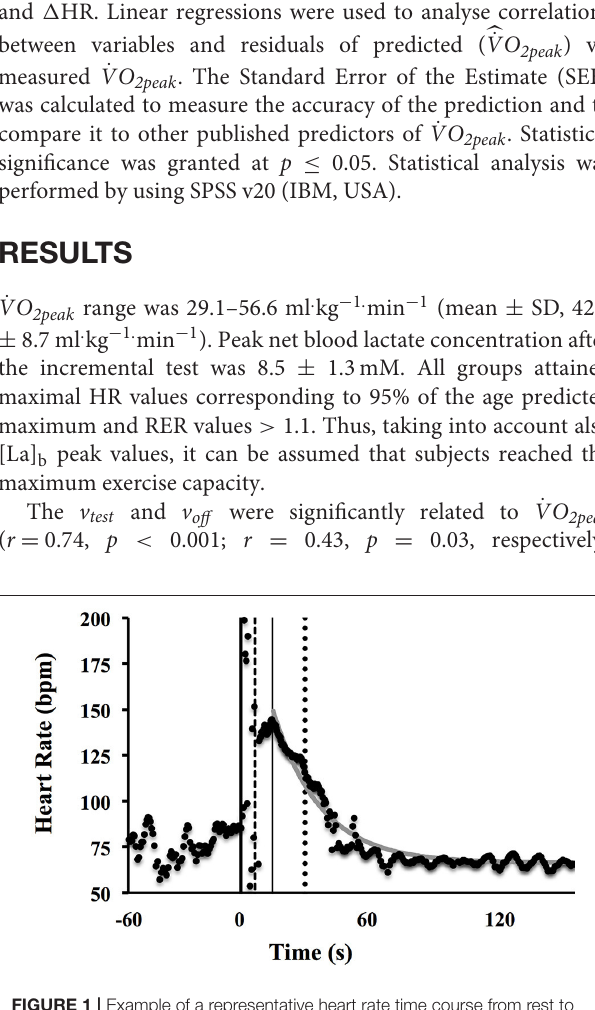
FIGURE 1 | Example of a representative heart rate time course from rest to recovery of the maximal sprint test. The thick vertical line coincides with the start of the sprint, the dashed vertical line with the end of the sprint, the thin vertical line represents the start decay of HR, while the dotted line expresses the τ off and the gray continuous curve represents the mono-exponential best